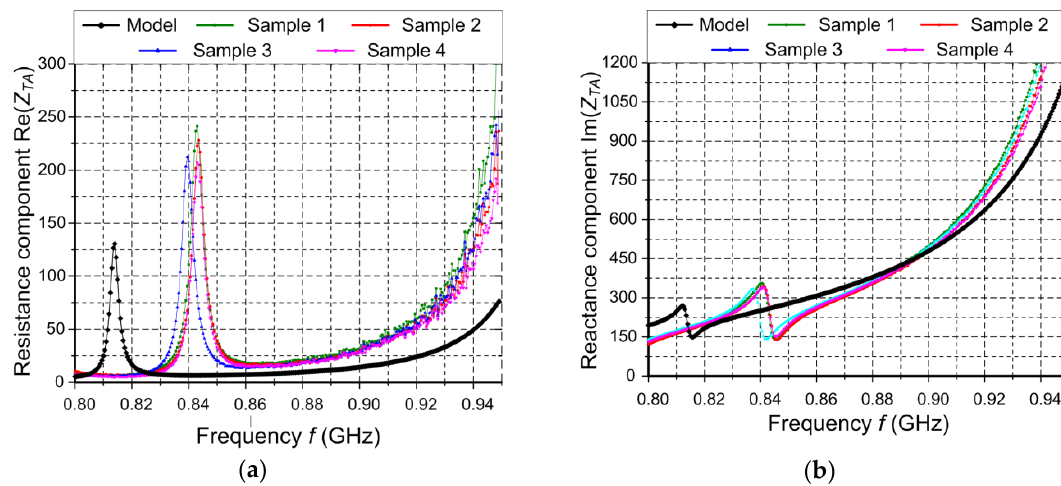
Figure 9. Impedance parameters of transponder antenna as a function of frequency f : ( a ) Resistance component; ( b ) Reactance component; Z TA —antenna impedance; Re—real part of complex number; Im—imaginary part of complex number; f —frequency.